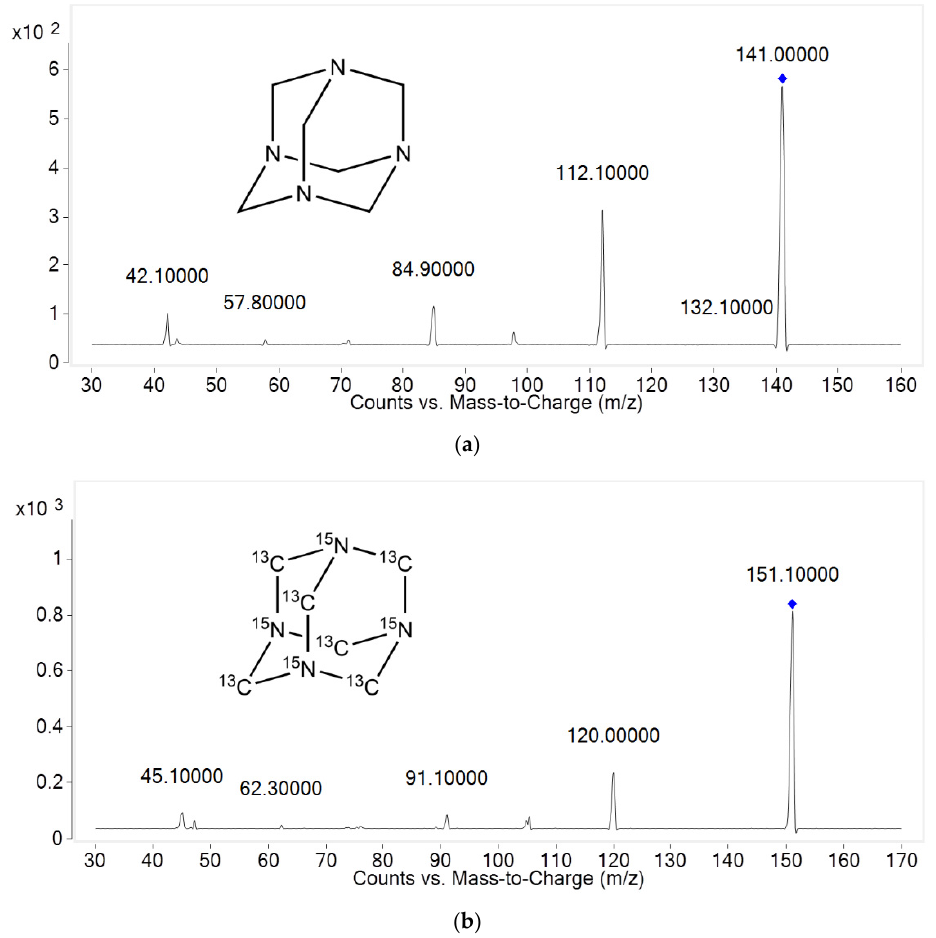
Figure 1. Product ion mass spectra of protonated ( a ) hexamethylenetetramine (141.0 → 112.1) and ( b ) I.S. (151.1 → 120.0) in positive ionization mode. Table 1. Slopes, intercepts, and coefficients of determination of calibration curves. Batch Slope